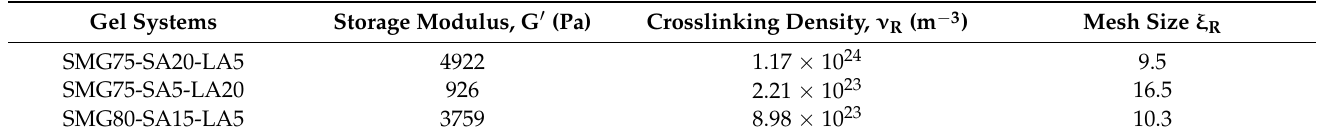
Table 2. Mechanical properties and crosslinking densities of the SMGs. Gel Systems Storage Modulus, G (cid:48)